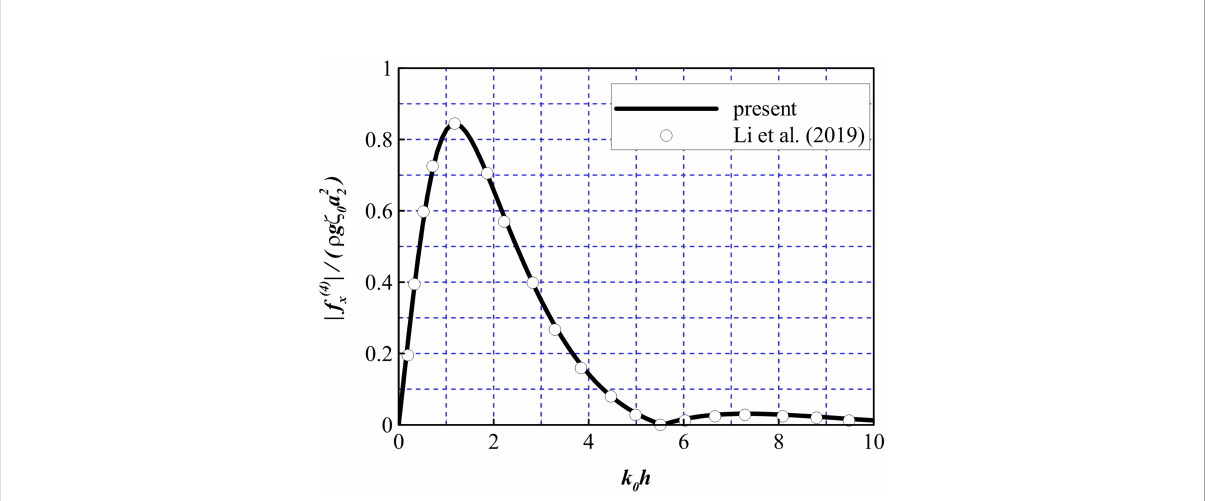
FIGURE 3 Comparison of the non-dimensional horizontal force to the results derived by Li et al.